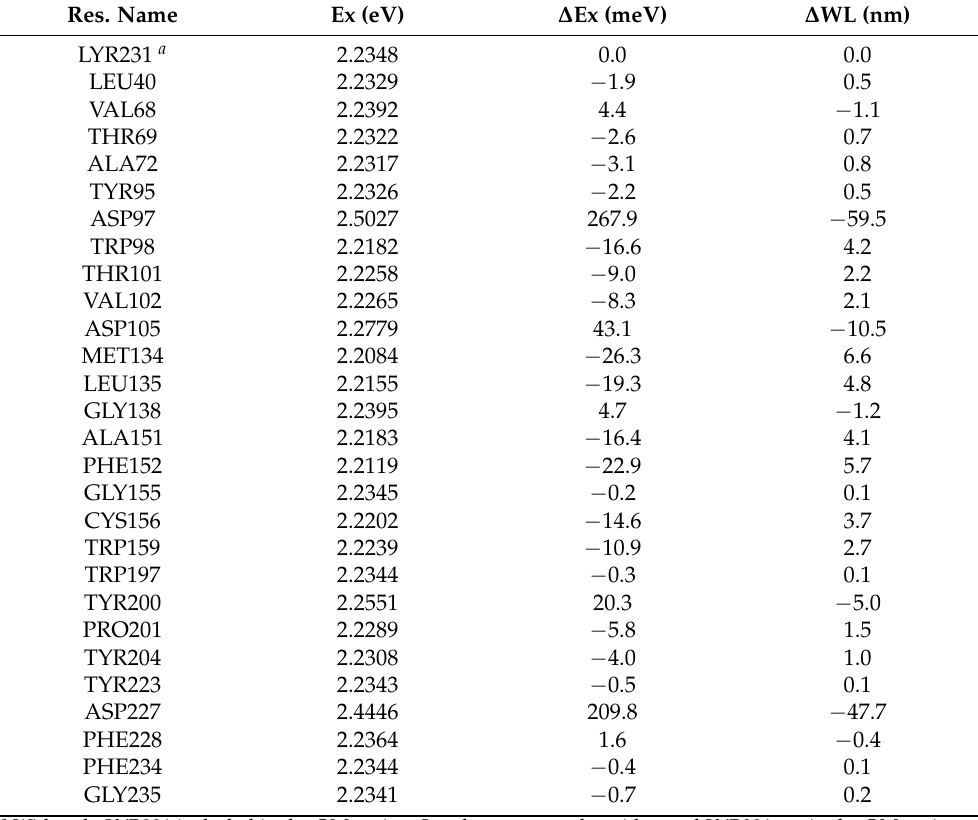
Table 2. Excitation energy decomposition per residue based on an ensemble average over 100 confor- mations. The residues are spatially in close contact with the chromophore and their QM contributions are calculated by GMFCC at the TD-B3LYP/6-31G* level. “Ex” represents the excitation energy in eV. ∆ Ex represents the excitation energy difference between 2B (residue + LYR231) and LYR231. ∆ WL represents the wavelength difference between 2B (residue + LYR231) and LYR231 in